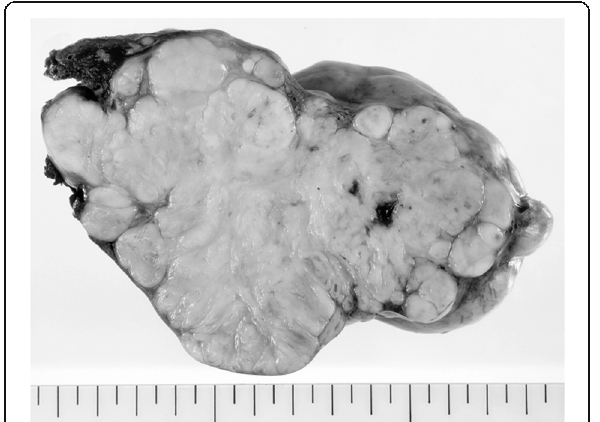
Fig. 2 MRI demonstrated a large tumor and multiple intrahepatic metastases